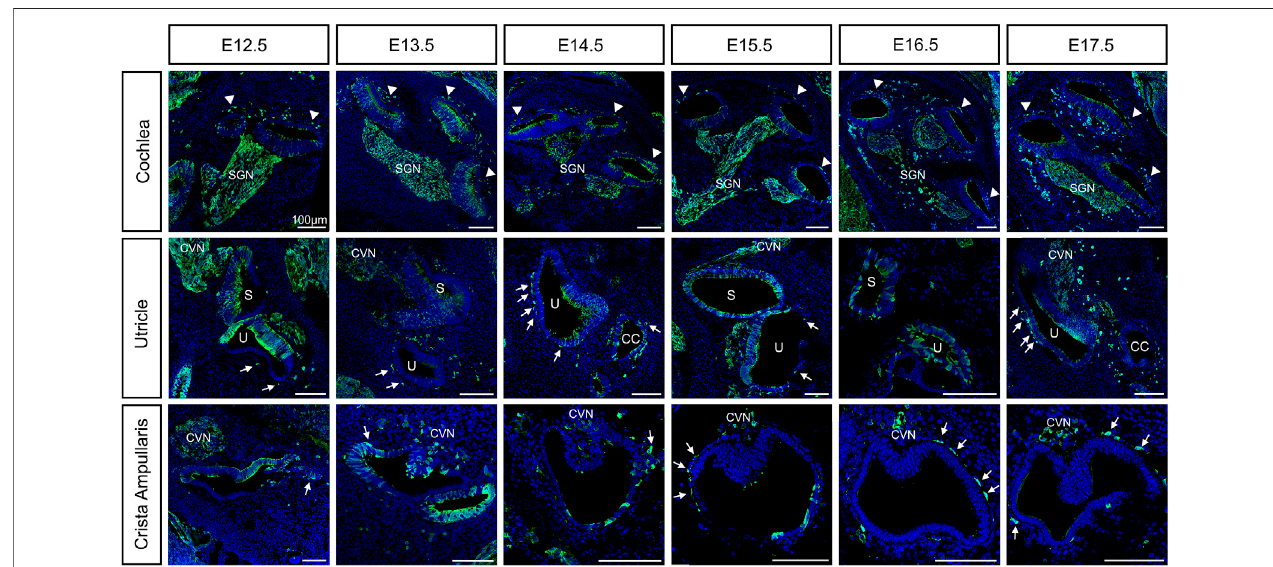
FIGURE 1 | Neural crest contributions to the inner ear during embryonic development from E12.5 to E17.5. Lineage tracing of neural crest cells using Wnt1-Cre2 mice crossed to an EYFP reporter line was visualized by staining with the anti-GFP antibody in green and DAPI for nucleus in blue. Arrowheads: intermediate cells of the stria vascularis; Arrows: melanoblast of the vestibule; CVN: Cochleo-vestibular neurons; SGN: Spiral ganglion neurons; S: saccule; U: utricle. Scale bars: 100 µm.